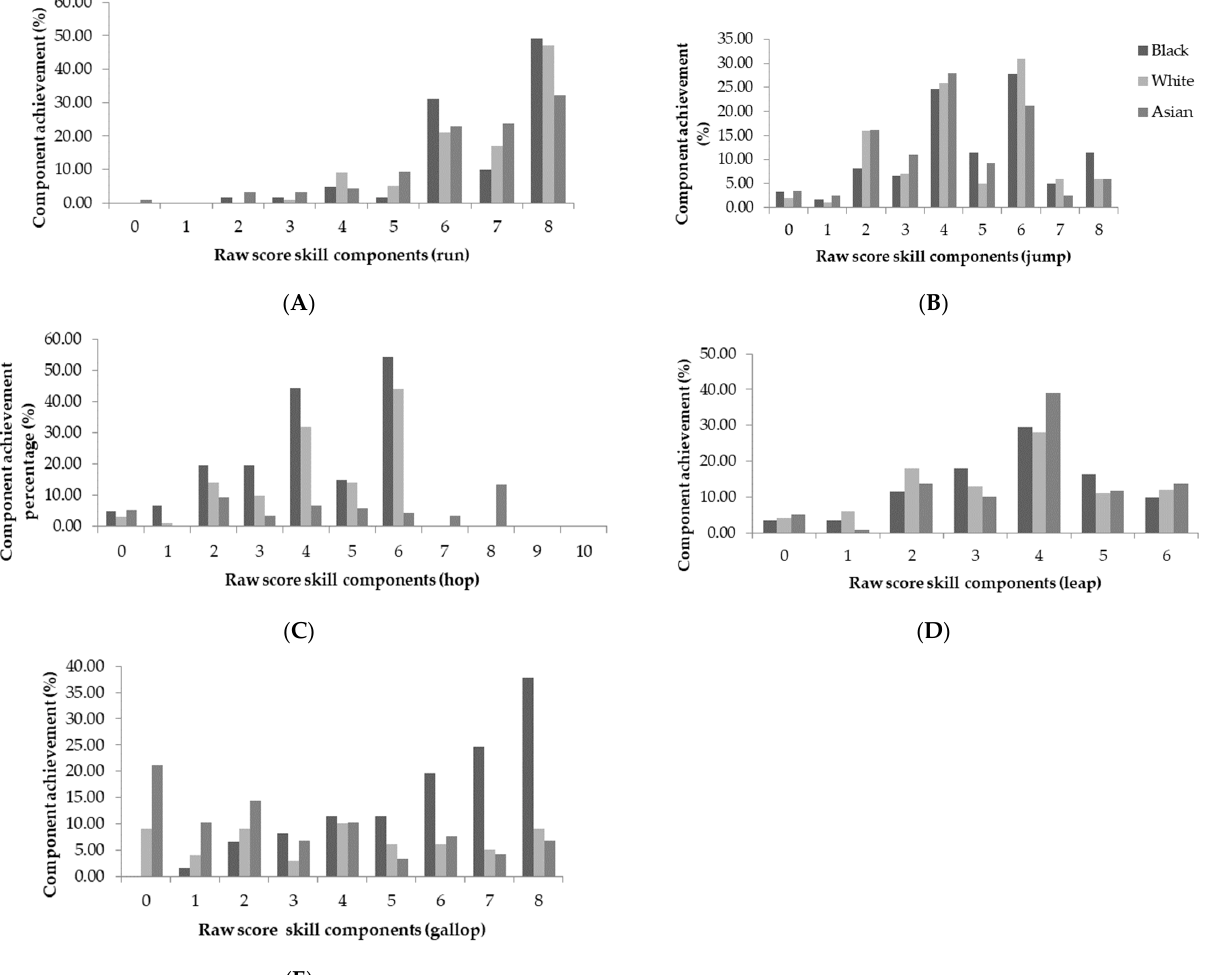
Figure 4. Component achievement (%) of locomotor skills by ethnicity; ( A ) Run; ( B ) Jump; ( C ) Hop; ( D ) Leap; and ( E ) Gallop.